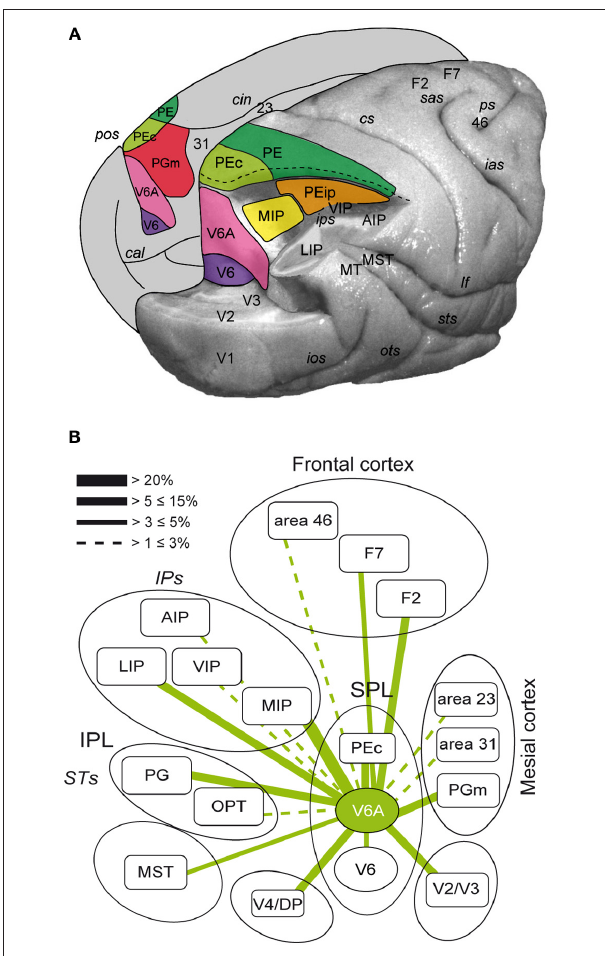
FIGURE 1 | (A) Location and extent of the areas that form the superior parietal cortex of the macaque brain. Posterolateral view of a partially dissected macaque brain modified from Galletti et al. (1996). The occipital pole has been partially removed and inferior parietal lobule of the right hemisphere has been cut away at the level of the fundus of the intraparietal sulcus to show the cortex of the medial bank of this sulcus. The occipital lobe of the same hemisphere has been cut away at the level of the fundus of the parieto-occipital and lunate sulci to show the cortex of the anterior bank of the parieto-occipital sulcus. The medial surface of the left hemisphere is drawn to show the location on it of all areas that extend medially. pos, parieto-occipital sulcus; cal, calcarine sulcus; cin, cingulate sulcus; ips, intraparietal sulcus; ios, inferior-occipital sulcus; ots, occipitotemporal sulcus; sts, superior temporal sulcus; lf, lateral fissure; cs, central sulcus; sas, superior arcuate sulcus; ias, inferior arcuate sulcus; ps, principal sulcus; V6, area V6; V3, area V3; V2, area V2; V1, area V1; PEc, area caudal PE; PE, area PE; PEip, intraparietal area PE; MIP, medial intraparietal area, PGm, area medial PG; VIP, ventral intraparietal area; LIP, lateral intraparietal area; AIP, anterior intraparietal area; MT, middle temporal area; MST, medial superior temporal area; Brodmann’s areas 23, 31, 46, and dorsal premotor areas F2 and F7 in are also shown. (B) Flow chart of the connections of V6A modified from Passarelli et al. (2011). Rostral/caudal brain areas are shown at the top/bottom part of the figure. The thickness of the lines is proportional to the strength of each connection. Areas in the ventral part of the parieto-occipital sulcus (V6, ventral V6A) are dominated by visual input, whereas as one proceeds toward the dorsal part of V6A sensory association and visuomotor/premotor connections prevail. Inferior parietal lobule areas Opt and PG and occipital areas V4/DP are also